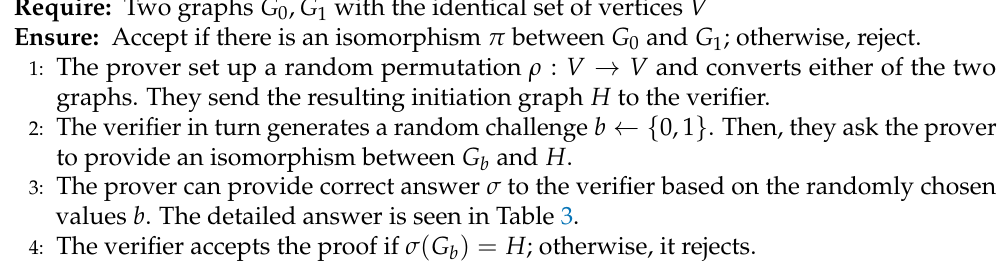
Figure 2. Two isomorphic graphs. Algorithm 1 Graph Isomorphism-based